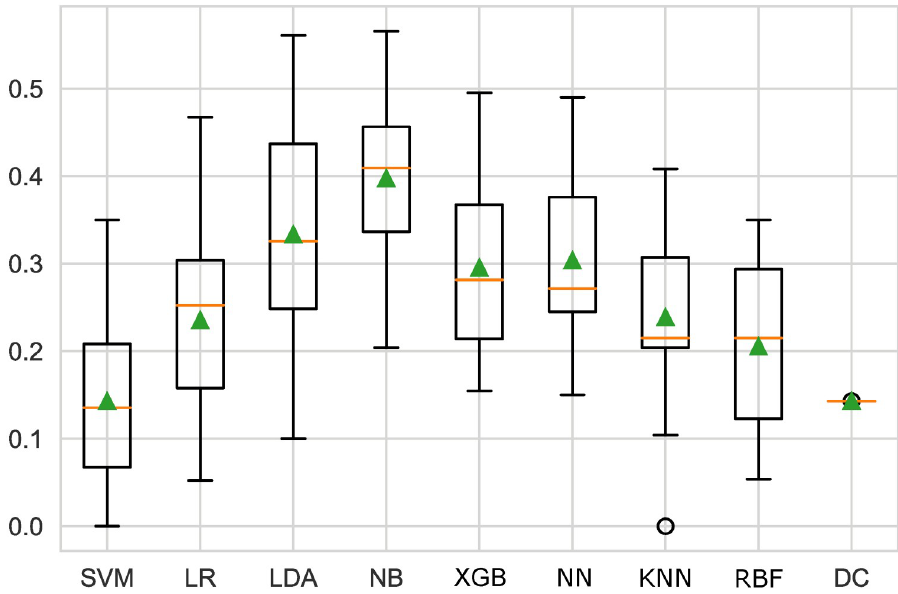
Fig 7. Boxplot of different models. Among all the models, NB had the best F2-score, followed by LDA with an F2-measure of 0.333; LR, XGB, and NN had almost the same score (0.235, 0.295, and 0.304, respectively); and SVM had the lowest score, which was equal to the baseline